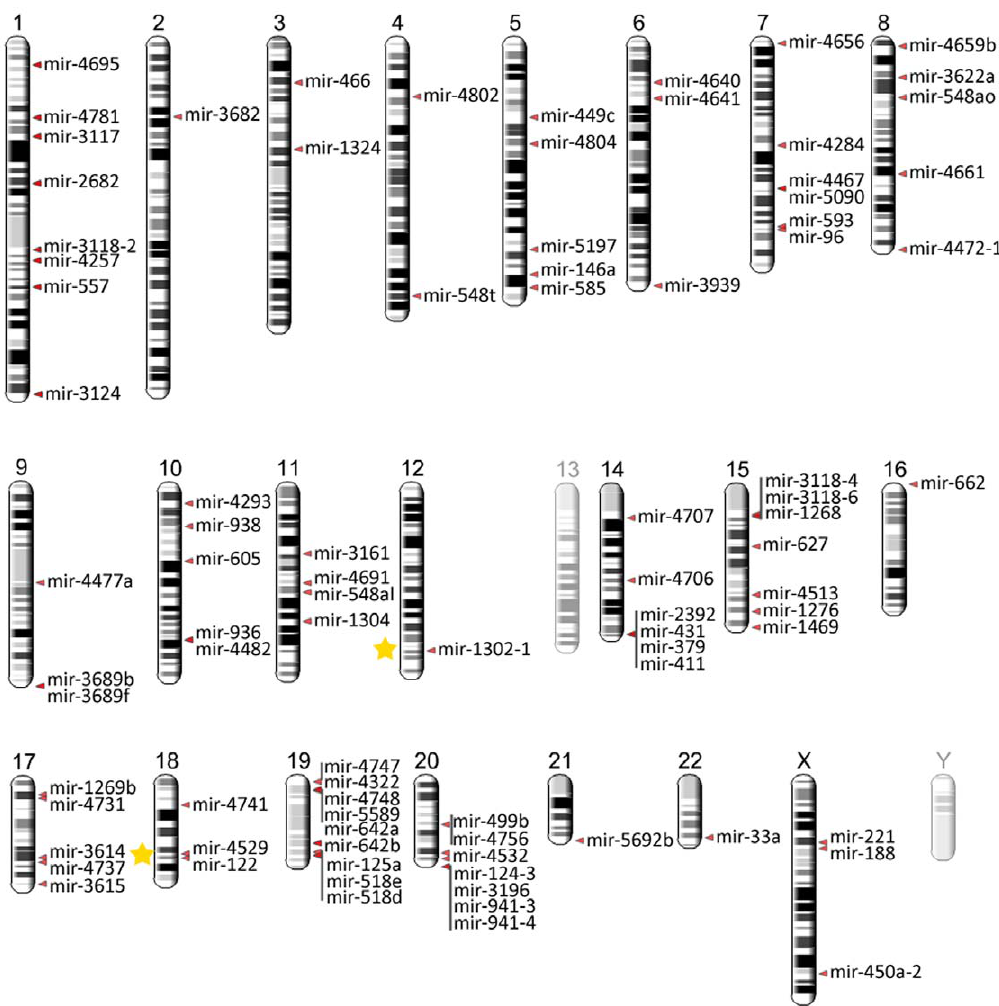
Figure 3. Genomic location of miRNAs with polymorphic seed regions in human. miRNAs comprising validated seed region polymorphisms mapping to two overlapping fragile sites are marked with yellow stars.